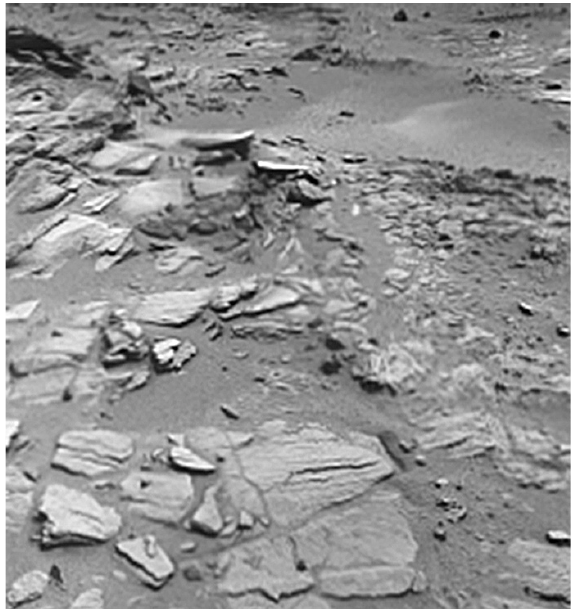
Figure 5 An example of 1.75x MSL Navcam SRR from 6 slightly shifted views.